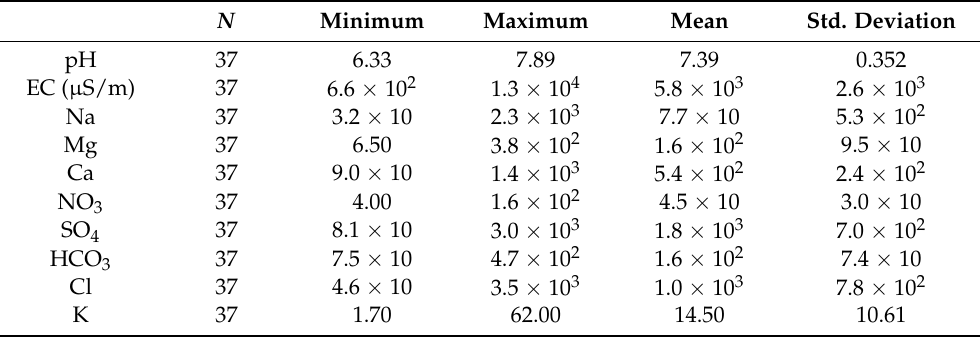
Table 1. Descriptive statistics of physicochemical parameters (contents in